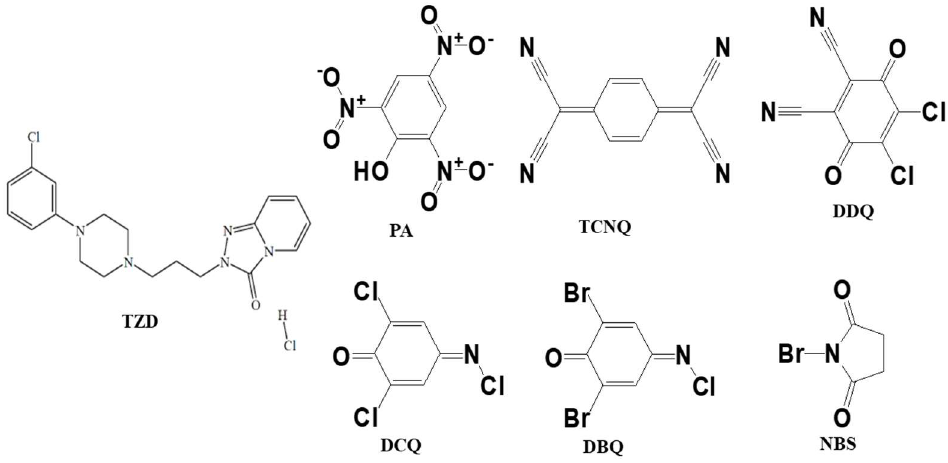
Figure 1. Structures of TZD and π-acceptors.